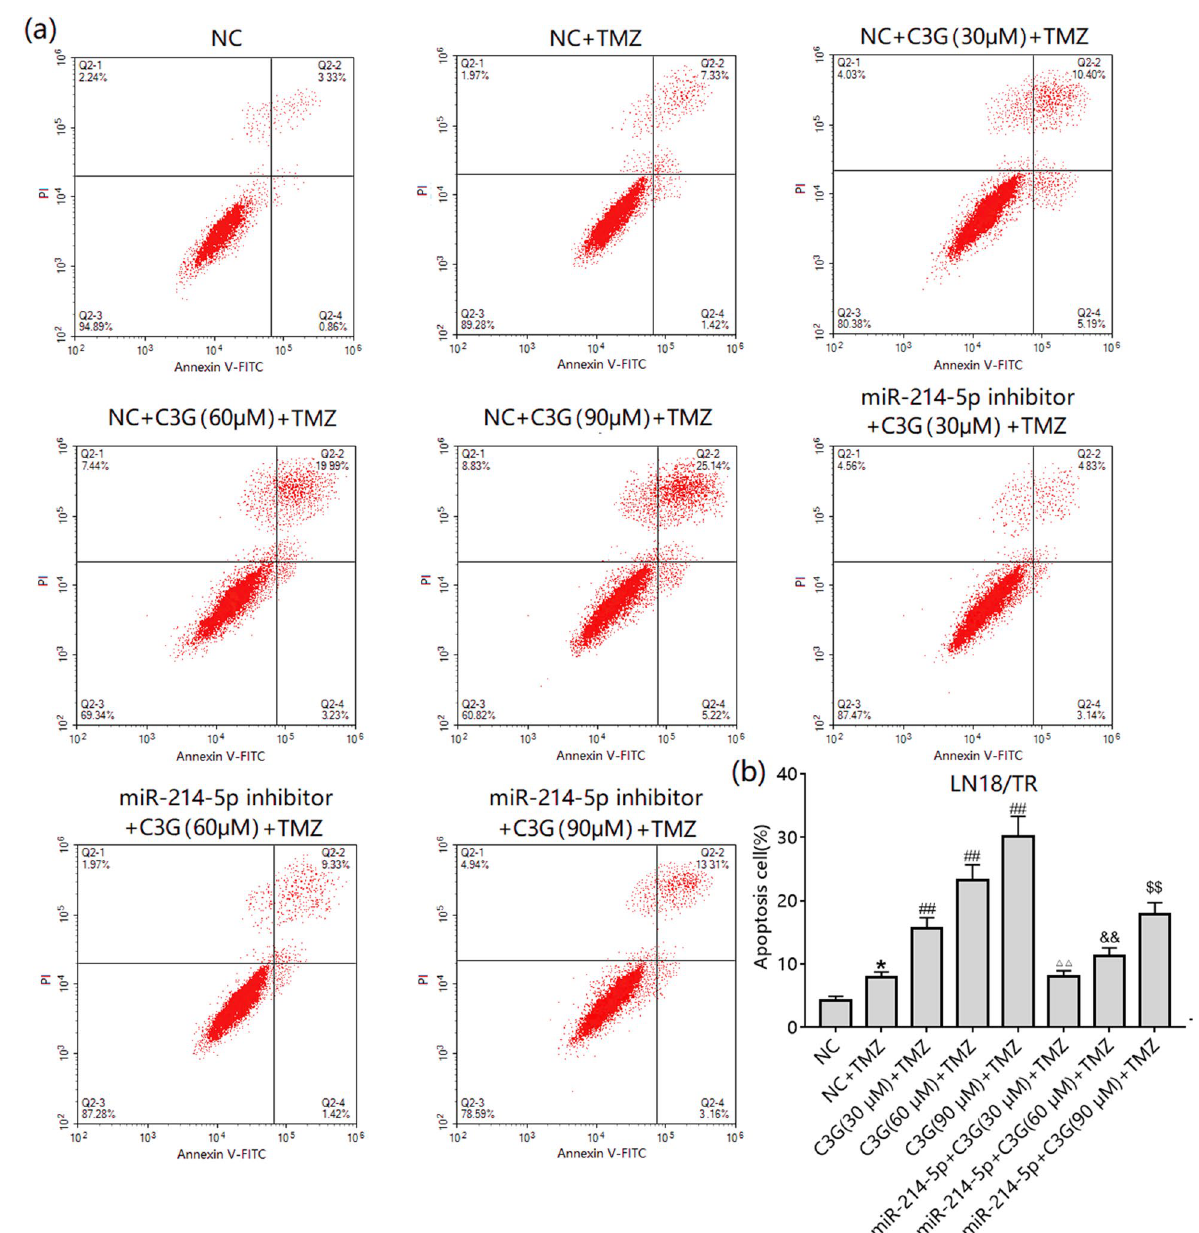
Figure 7. Cyanidin-3- O -glucoside (C3G) enhances the sensitivity of LN-18/TR cells to temozolomide (TMZ) by upregulating miR-214-5p. ( a ) LN-18/TR cells transfected with NC or miR-214-5p inhibitor were treated